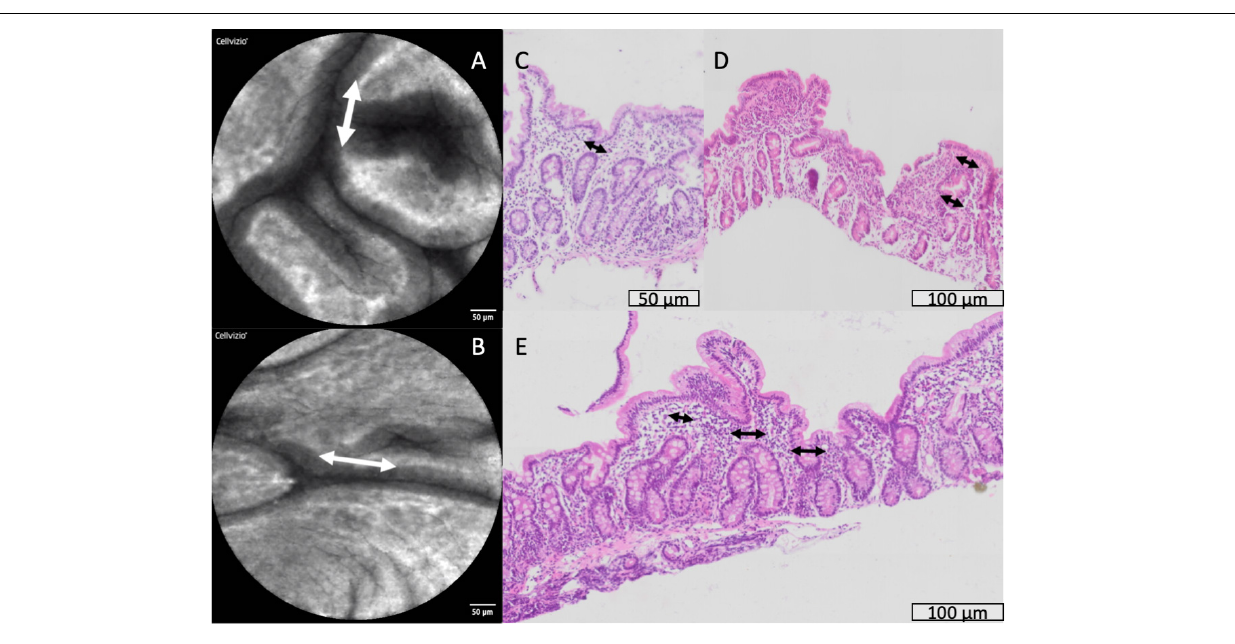
FIGURE 7 | Synechiae (epithelial bridges, marked with arrows) progressing to villus fusion. These are shown by confocal laser endomicroscopy (A,B) and histology (C–E)